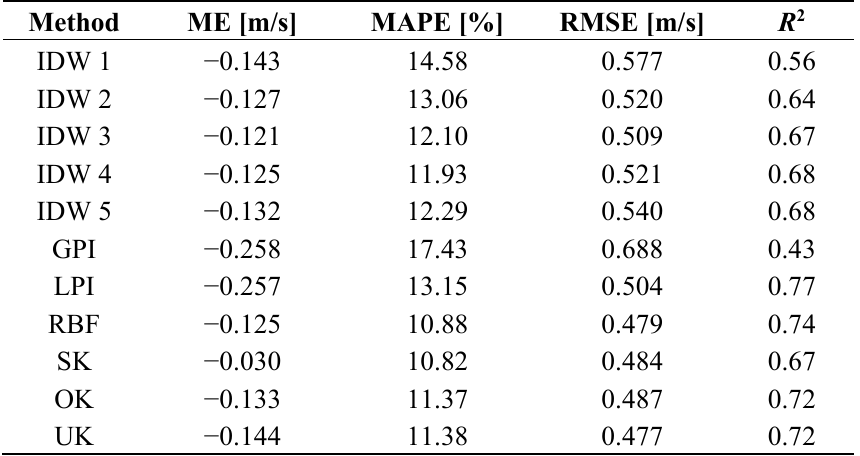
Table 3. LOOCV statistical values for the different spatial interpolation